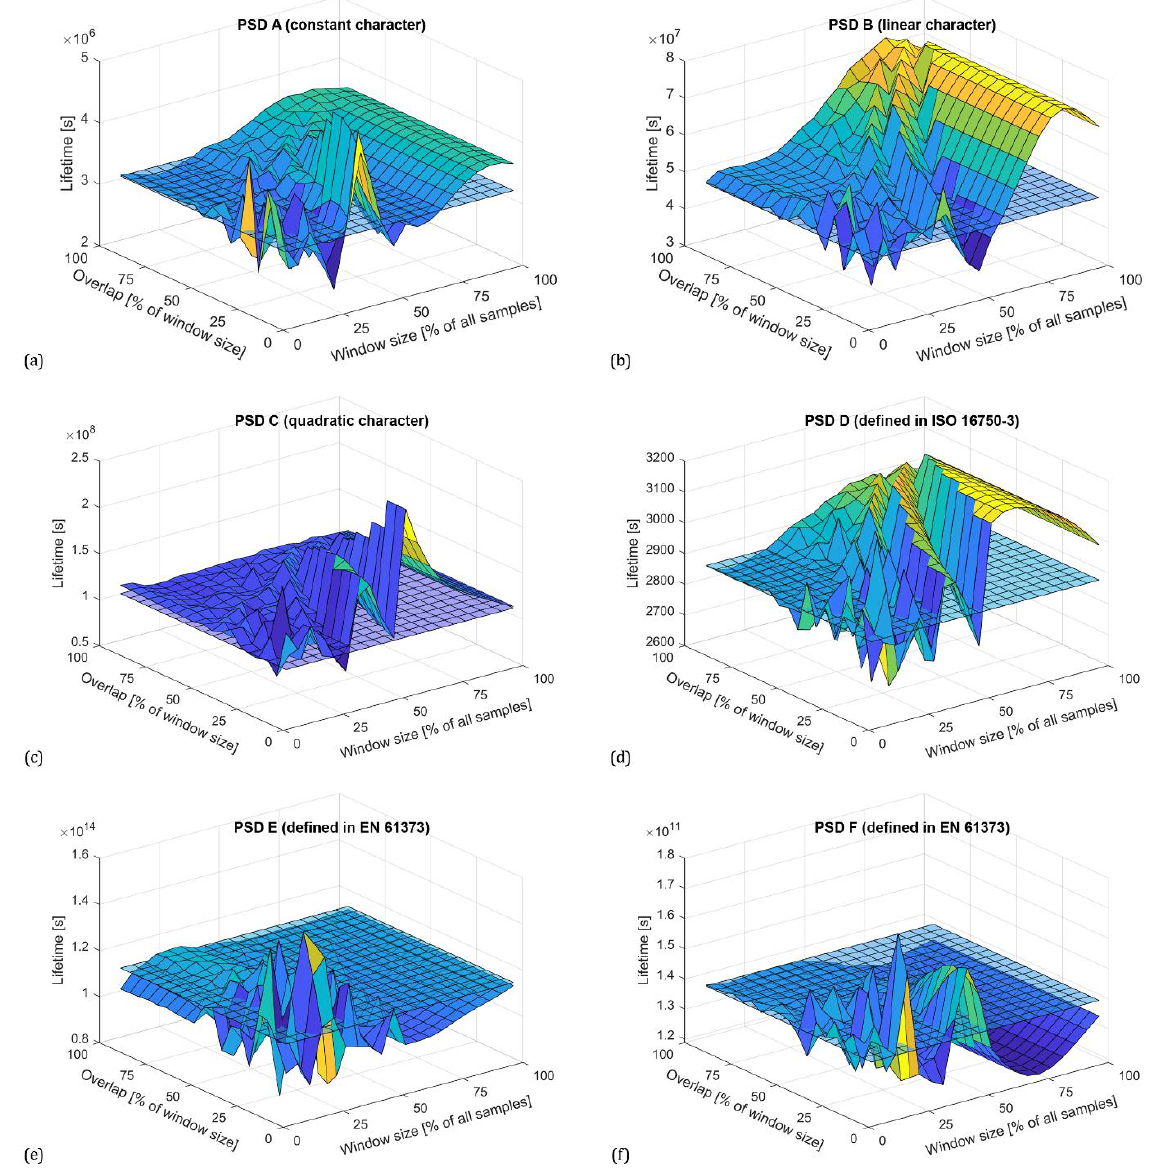
Figure 10. Fatigue life estimates determined by Dirlik probability model (Hanning window). Comparisons prepared according to PSD using constants (a), constants with linear connection (b), constants with quadratic connection (c), standardized PSD functions according to ISO 16750-3 (d) and EN 61373 (e)-(f).